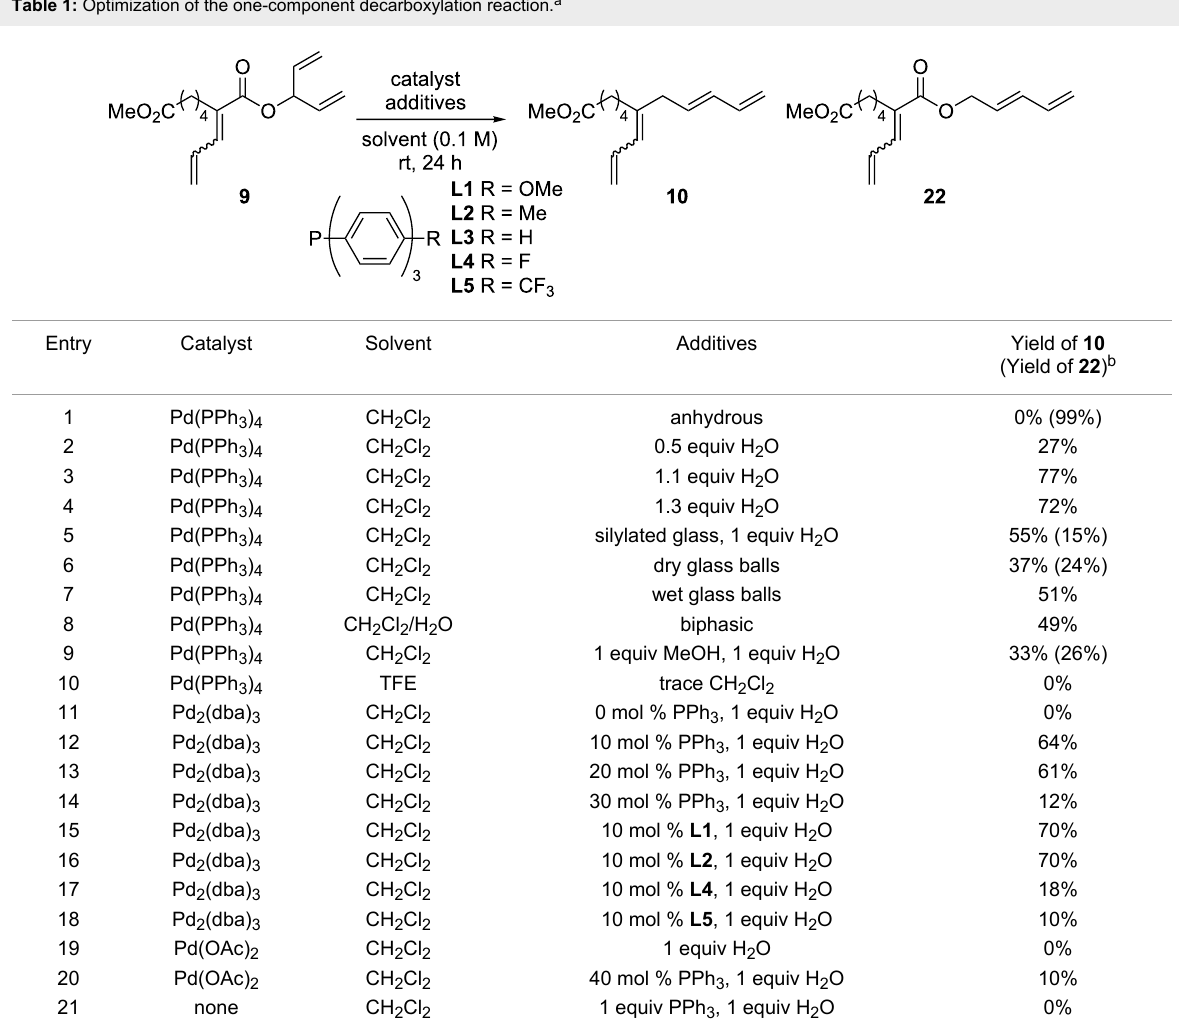
Table 1: Optimization of the one-component decarboxylation reaction.